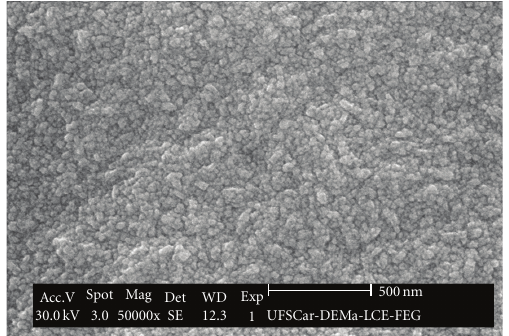
Figure 1: FEG-SEM image of undoped NCD film grown on a silicon substrate.